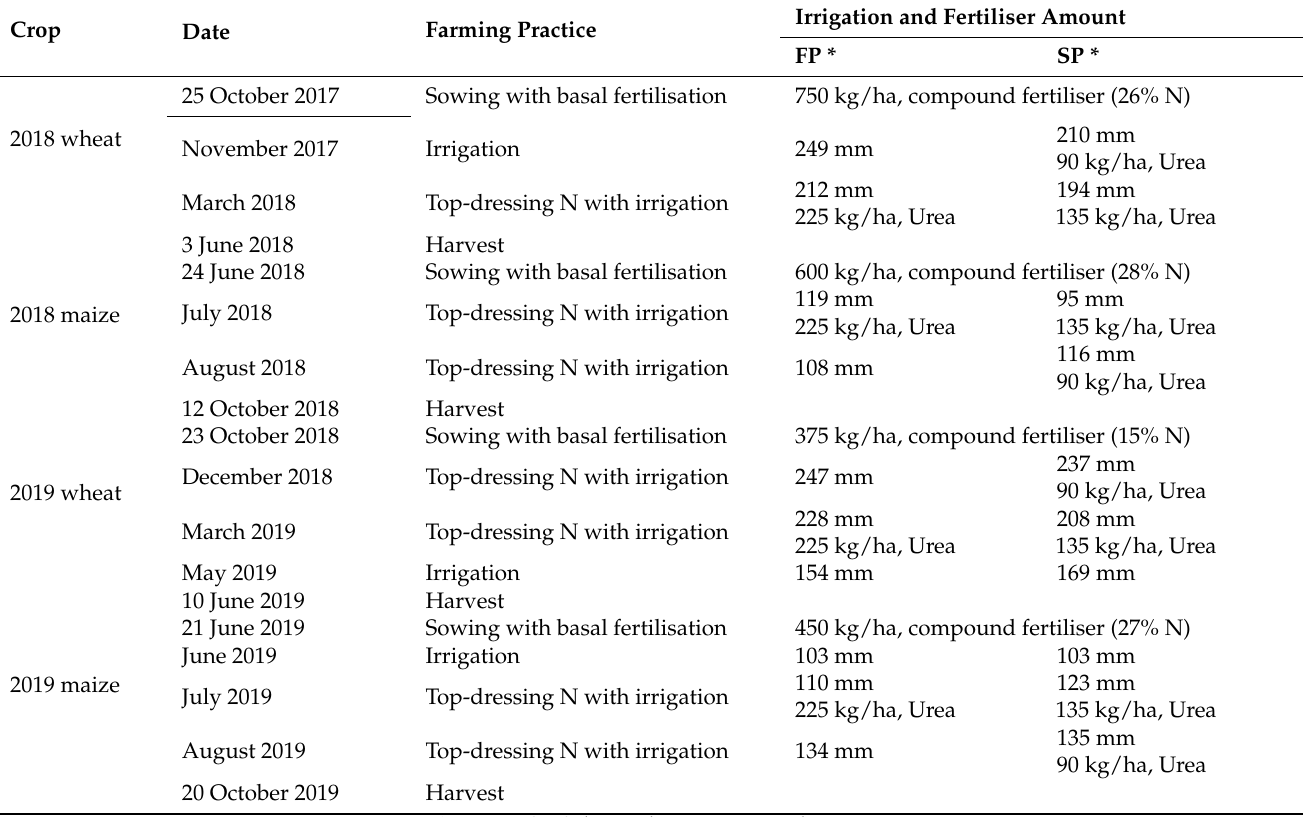
Table 1. Crop calendar and field